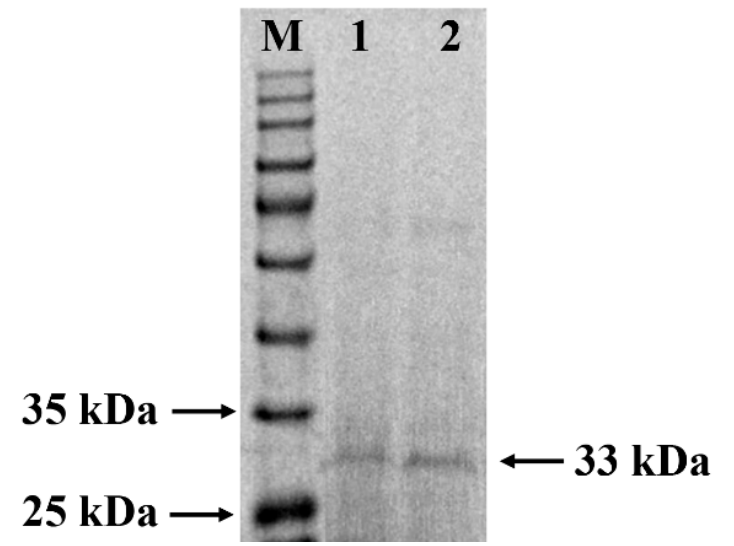
Figure 1. SDS-PAGE of purified W. cibaria F1 mannanase. Lane M: protein marker; Lane 1 and 2: purified W. cibaria F1 mannanase.